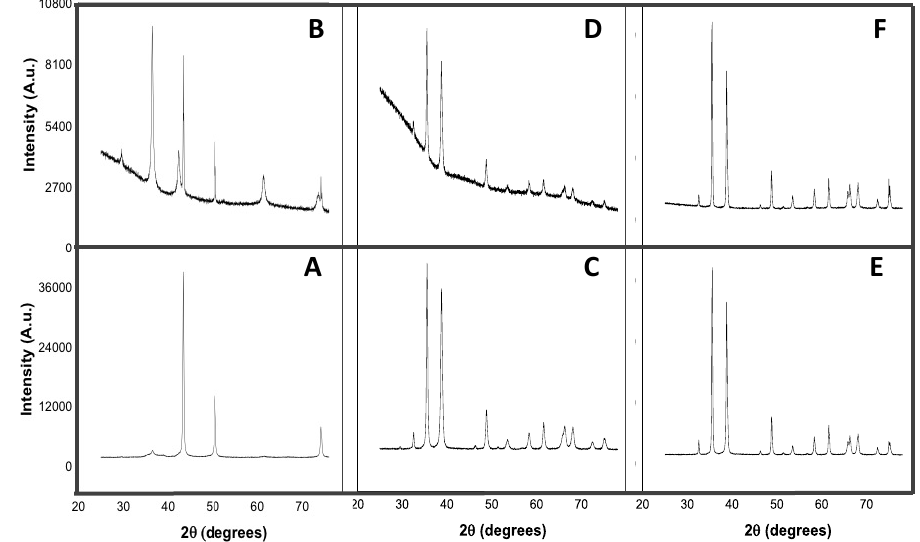
Figure 3. X-ray diffraction (XRD) patterns of Cu-NPs, CuO-NPs, and CuO before (respectively A , C , E ) and after ( B , D , F , respectively) interaction with the C. gloeosp for seven days. Patterns were obtained with a PANalytical X’PERT PRO MPD diffractometer (Malvern Panalytical, Japan) operating at 45 kV and 40 mA with Cu-K α radiation ( λ = 1.54060 A ̊ ) at a scan speed of 0.01 from the 2 θ 20° to 80° range.